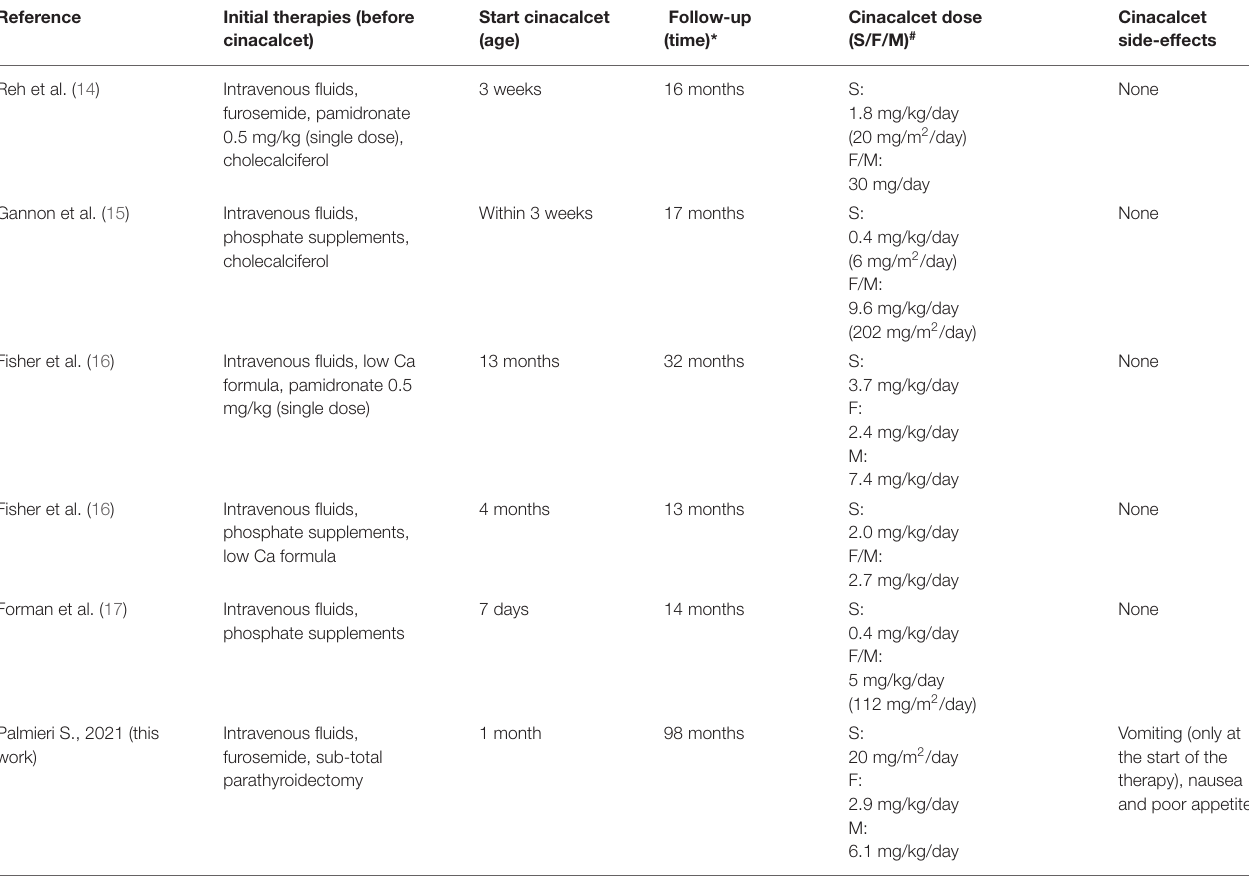
TABLE 1 | Literature review of NSHPT due to heterozygous R185Q CaSR mutation successfully treated with cinacalcet